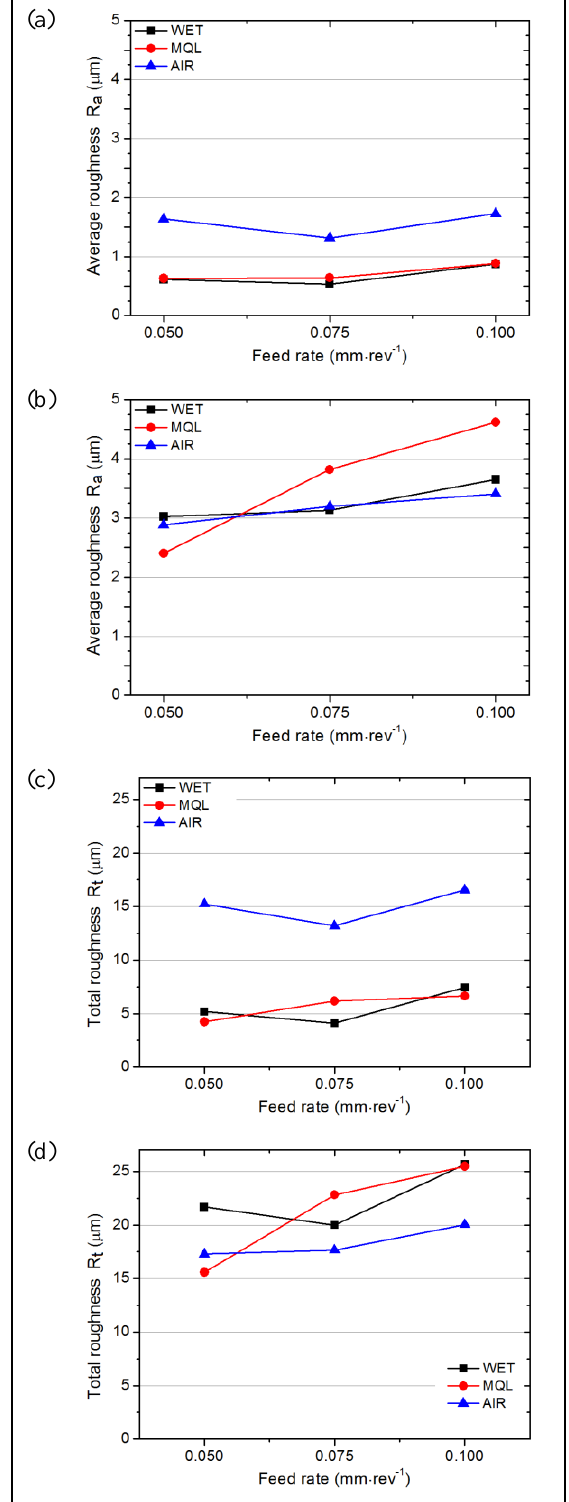
Figure 6: Effect of feed rate on: (a) average roughness ( R a ) for SG; (b) average roughness ( R a ) for PG; (c) total roughness ( R t ) for SG; (d) total roughness ( R t ) for